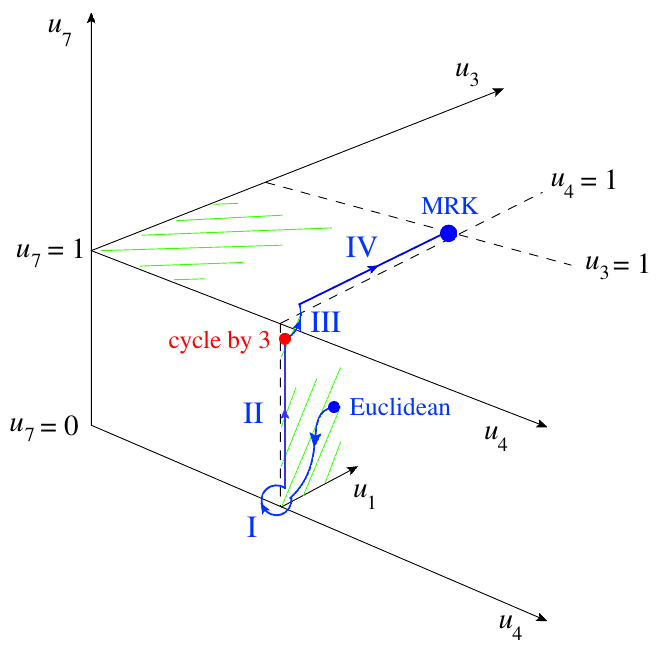
Figure 1 . A sequence of paths from the Euclidean CO surface to MRK. It is a bit schematic in order to depict motion in four different variables, u 7 , u 1 , u 3 , u 4 . Starting from the Euclidean branch of the surface CO ( u 7 ,u 1 ) , in step I we analytically continue u 7 around its complex origin,